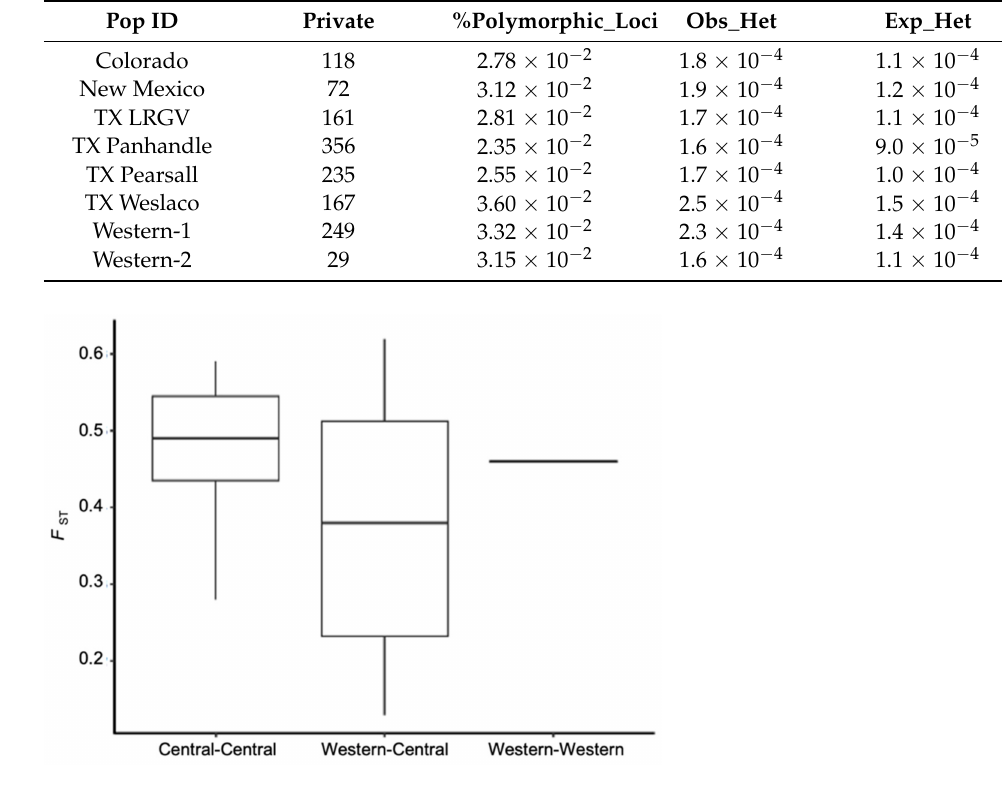
Figure 2. Pairwise F ST of psyllid populations separated by whether the pair were different haplotypes or the same haplotype. Note, only two populations were designated as Western haplotype in our study.